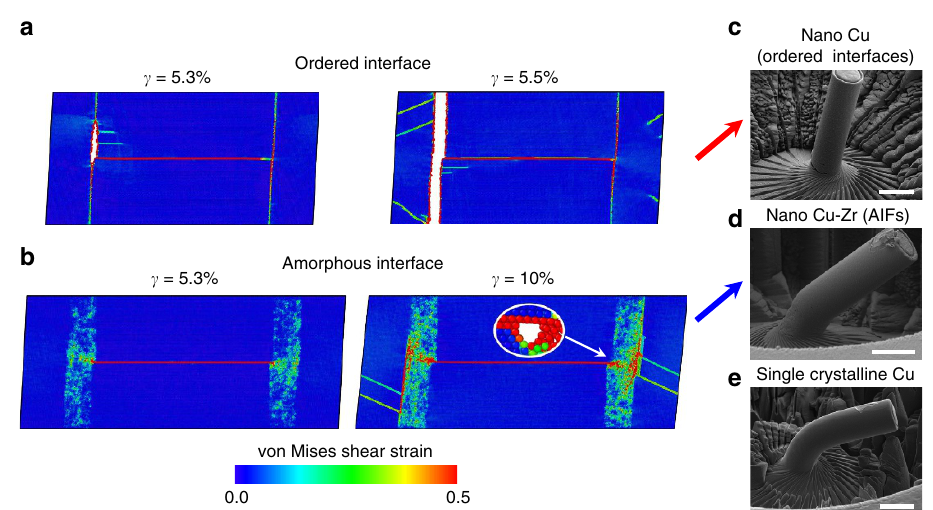
Figure 4 | Connection between interfacial structure and damage tolerance. Molecular dynamics simulations of dislocation absorption at ( a ) an ordered grain boundary and ( b ) an amorphous intergranular film show the formation and propagation of crack damage. The ordered interface quickly fractures, whereas the amorphous interface diffuses the strain concentration brought by dislocation absorption and fracture is delayed. The delay of failure explains why ( d ) nanocrystalline Cu-Zr with AIFs has ductility reminiscent of ( e ) coarse-grained Cu while retaining the high strength of ( c ) nanocrystalline Cu (scale bars, 5 m